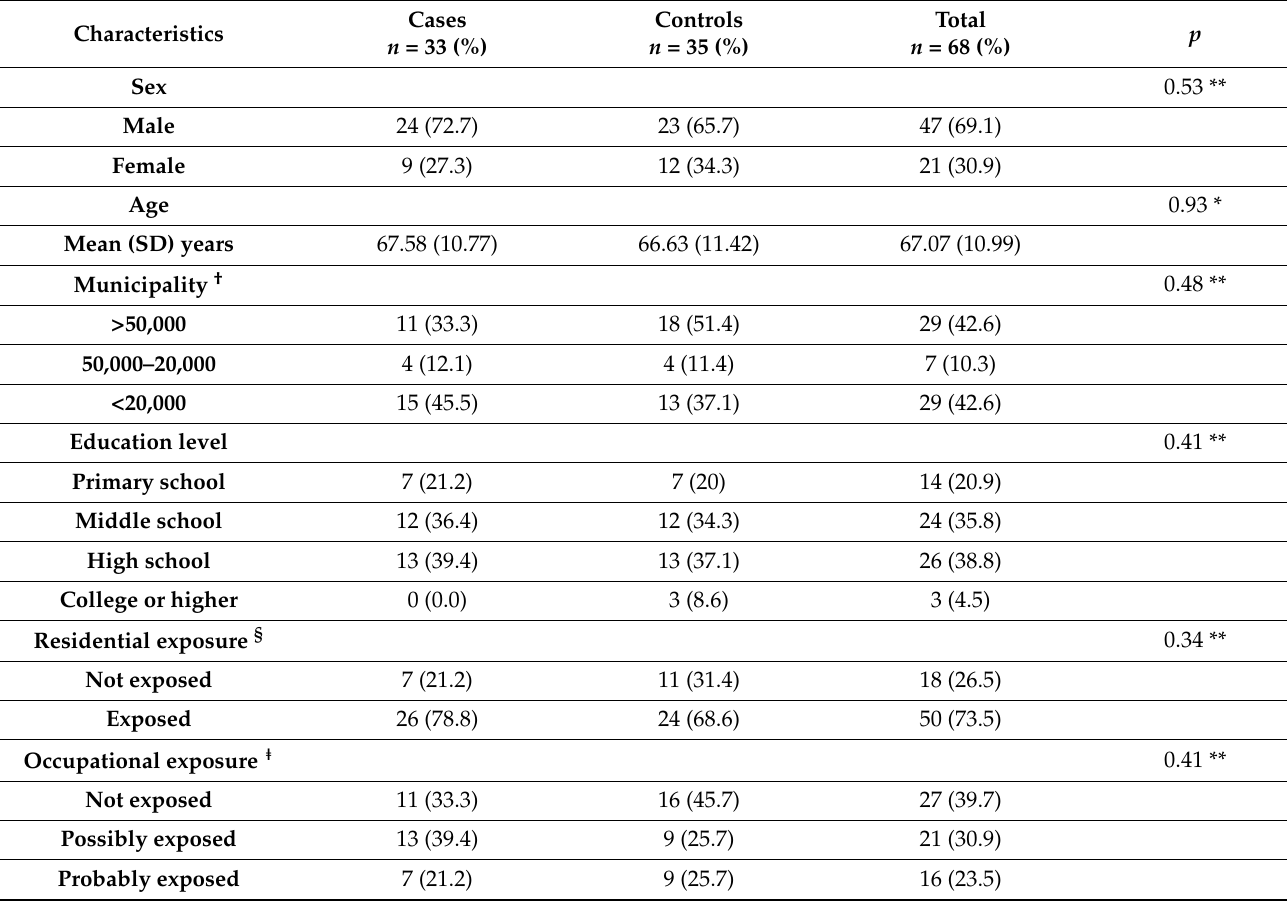
Table 1. Demographical characteristics, occupational and residential exposure of study population.